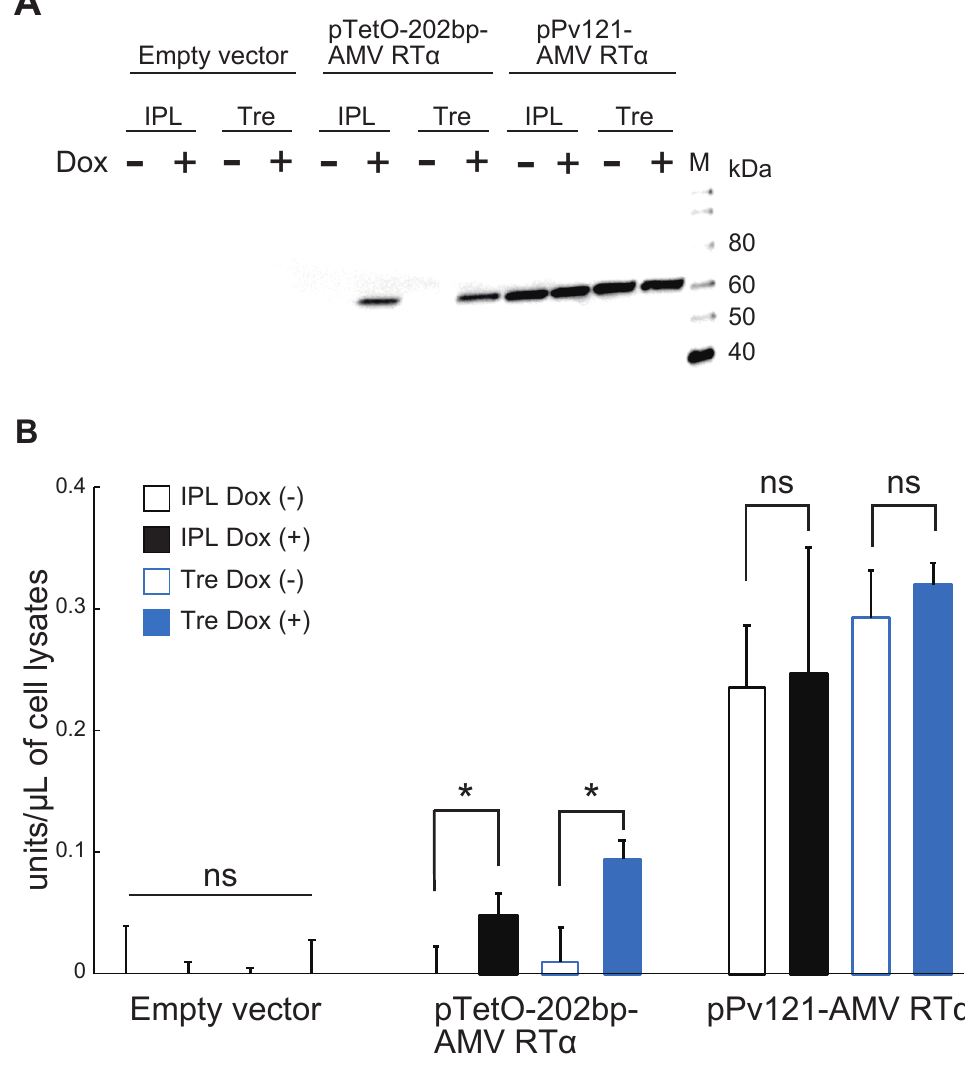
Figure 3. Avian myeloblastosis virus reverse transcriptase α subunit (AMV RT α ) expression and direct measurement of reverse transcriptase activity. ( A ) Western blot analysis was performed on extracts of Pv11 cells transfected with the indicated vectors. IPL, IPL-41 medium; Tre, 600 mM trehalose solution; Lane M, protein marker. ( B ) AMV RT α activities were measured directly in lysates of Pv11 cells transfected with the indicated vectors. Normalized values are expressed as mean ± standard deviation (SD). *, significant at p < 0.05; ns, not significant; n = 3 in each